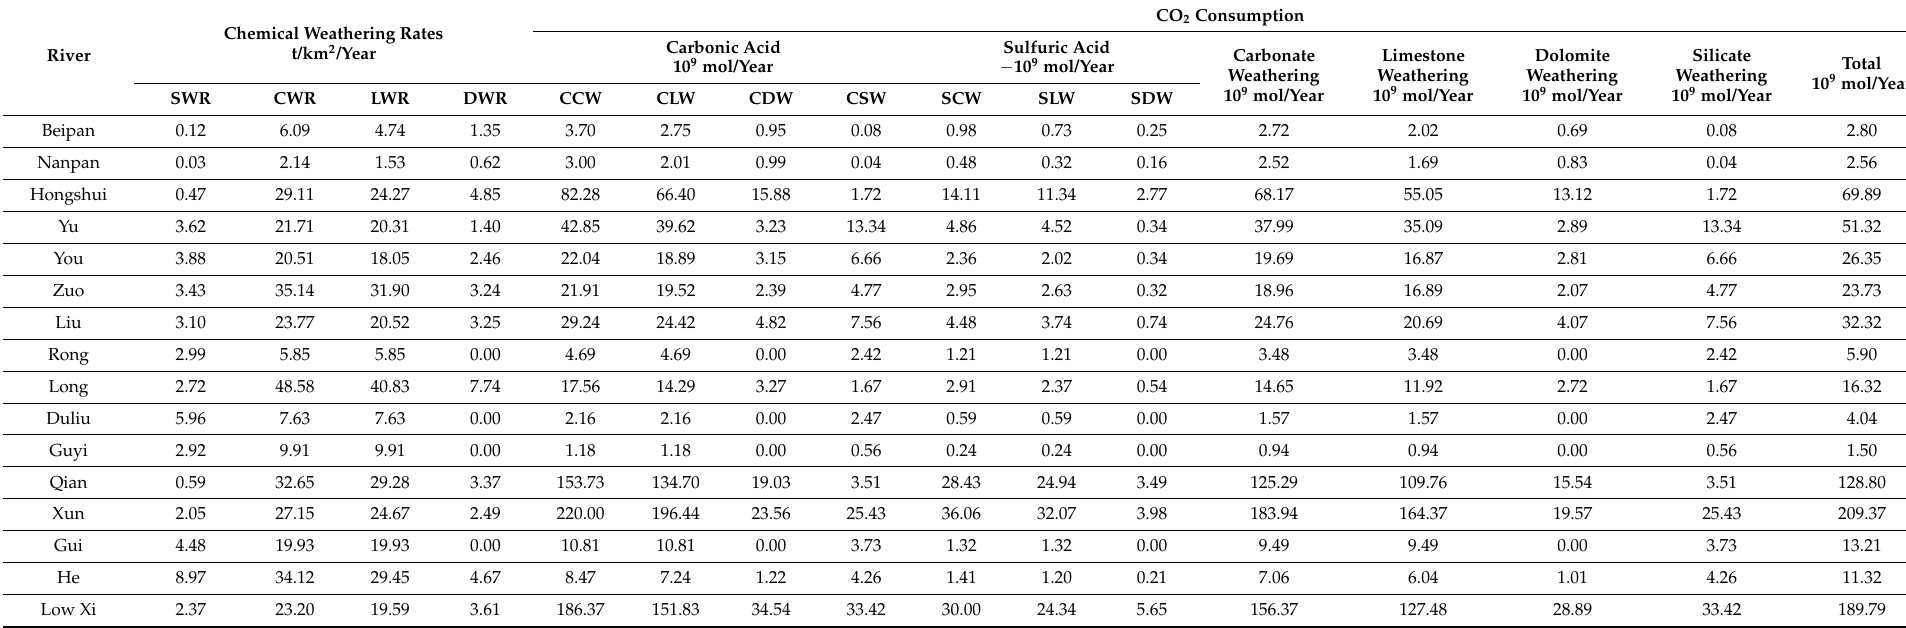
Table 5. Chemical weathering rates and CO 2 consumption for the main stream and main tributaries of the Xi